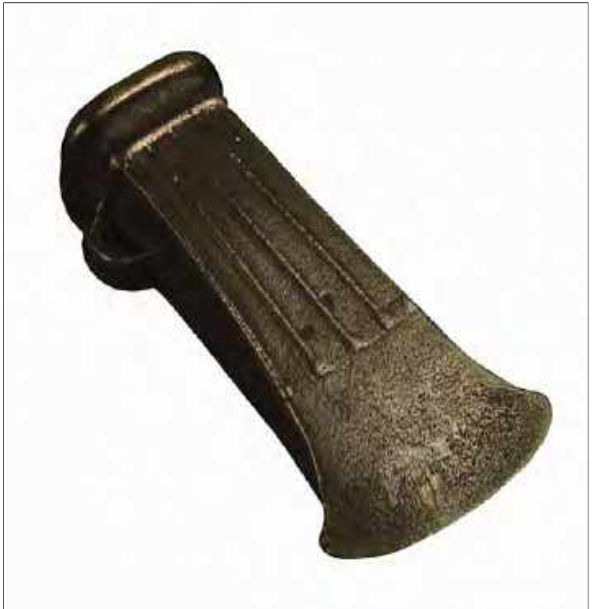
Fig 2.26 Late Bronze Age socketed axe blade from Tremlow, Cheshire (Cheshire County